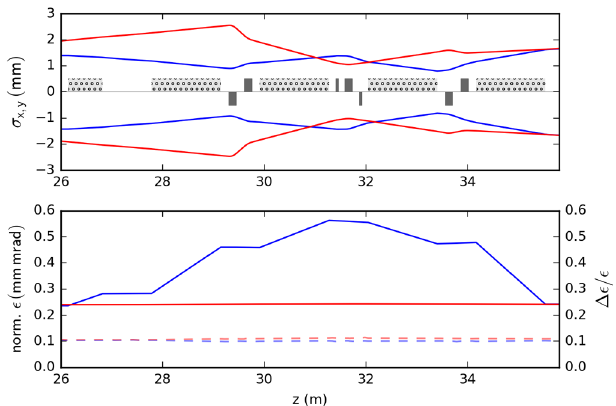
FIG. 14. rms beam envelope through the first arc with waterbag initial distribution and 40 mA bunch current.